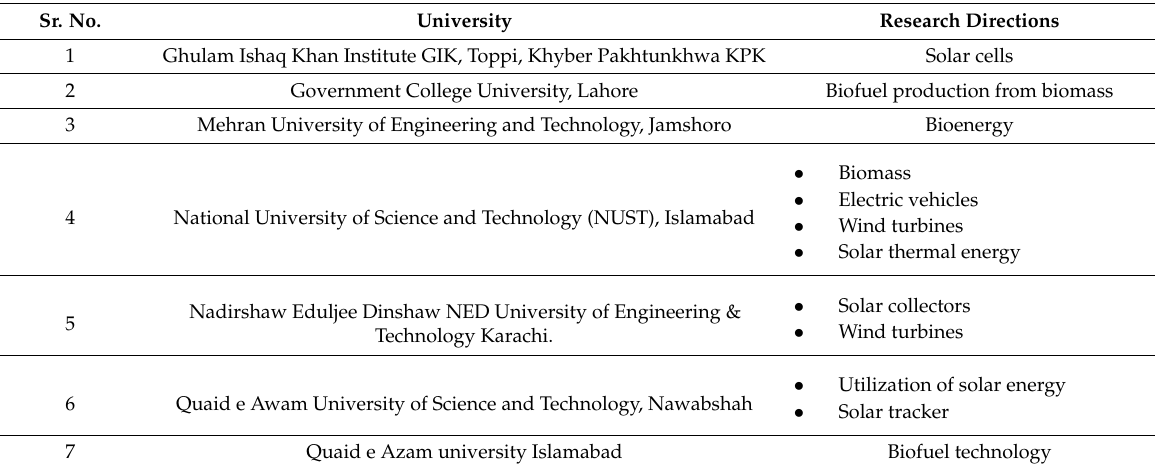
Table 25. Ongoing research on renewable energy resources and technologies in universities of Pakistan. Sr.